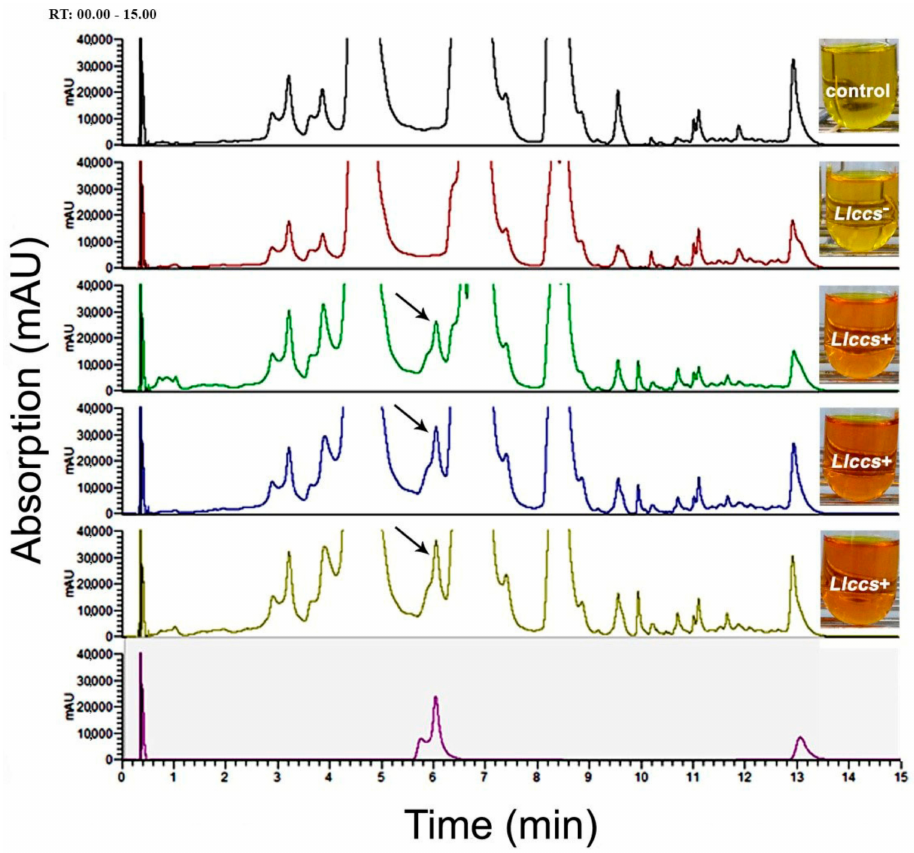
Figure 10. UHPLC chromatograms of saponified extracts isolated from petals of untransformed (control) , Llccs − and Llccs + flowers (lines 2, 3 and 7, respectively) of V. cornuta and capsanthin standard (1.0 µ g). The arrows indicate the capsanthin peak in Llccs + , 1.31, 1.76 and 1.62 µ g/g, respectively). Actual appearance of the analyzed extracts is indicated right of